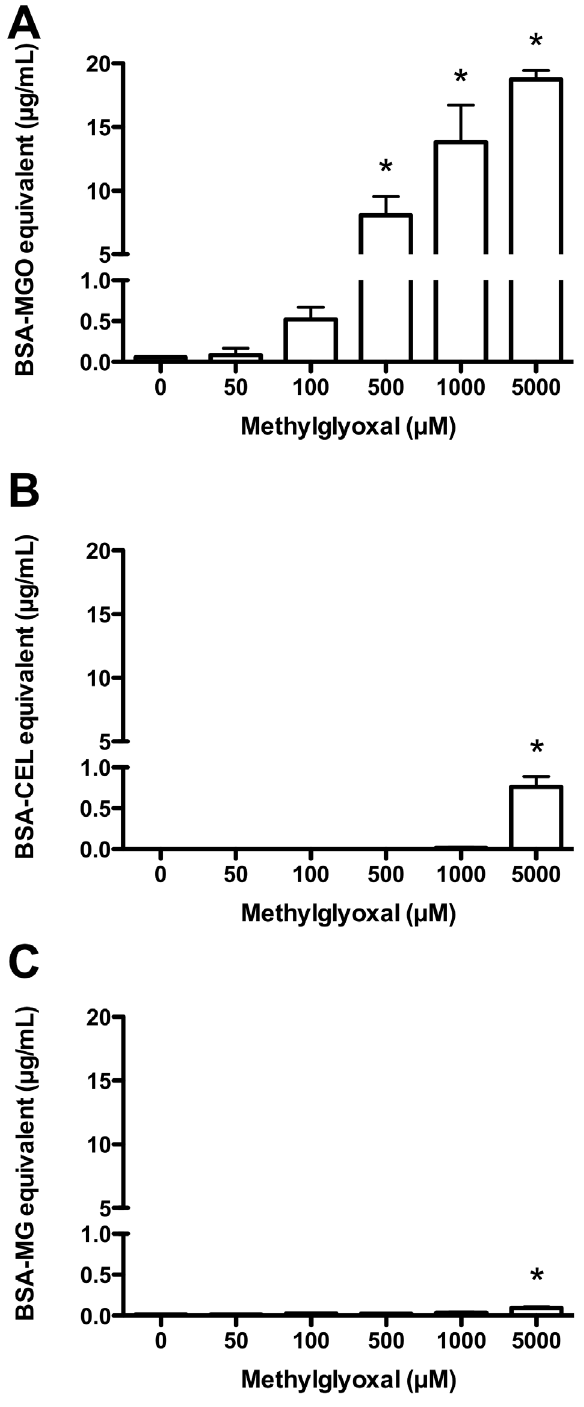
Figure 7. AGE formation on HCAEC lysates following incuba- tion with MGO. Pooled HCAEC lysates from 4 donors (1 mg protein/ mL) were incubated with 0–5 mM MGO for 1 h in PBS, with the formation of AGE determined by ELISA after cell lysis: (A) hydro- imidazolones; (B) CEL, and; (C) CML. Data are means + SEM of AGE formation for 3 independent incubations, each measured in duplicate ELISA wells. *Significant change in activity ( P , 0.05) compared to 0 mM control activity (one-way ANOVA with Tukey’s post-test).